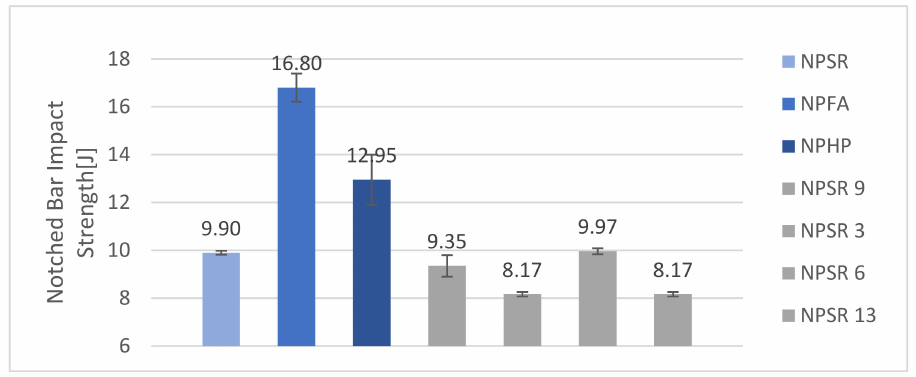
Figure 7. Notched bar impact strength for different heat treatments and DoE set parameters (Table 4) in the vertical